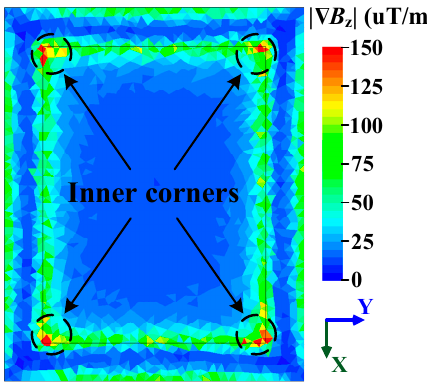
Figure 5. Distribution of the gradient magnitude | ∇ B z | on the plane 10 mm above the primary coil. To verify the optimal locations for the signal coils, three kinds of signal coils placement are simulated and compared, as shown in Figure 6. The primary coil is colored by green, and the signal coils are colored by pink. Their coordinates are also given in Figure 6.